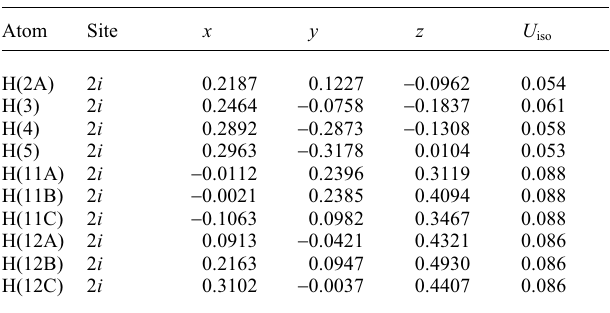
Table 2. Atomic coordinates and displacement parameters (in Å 2 ) .